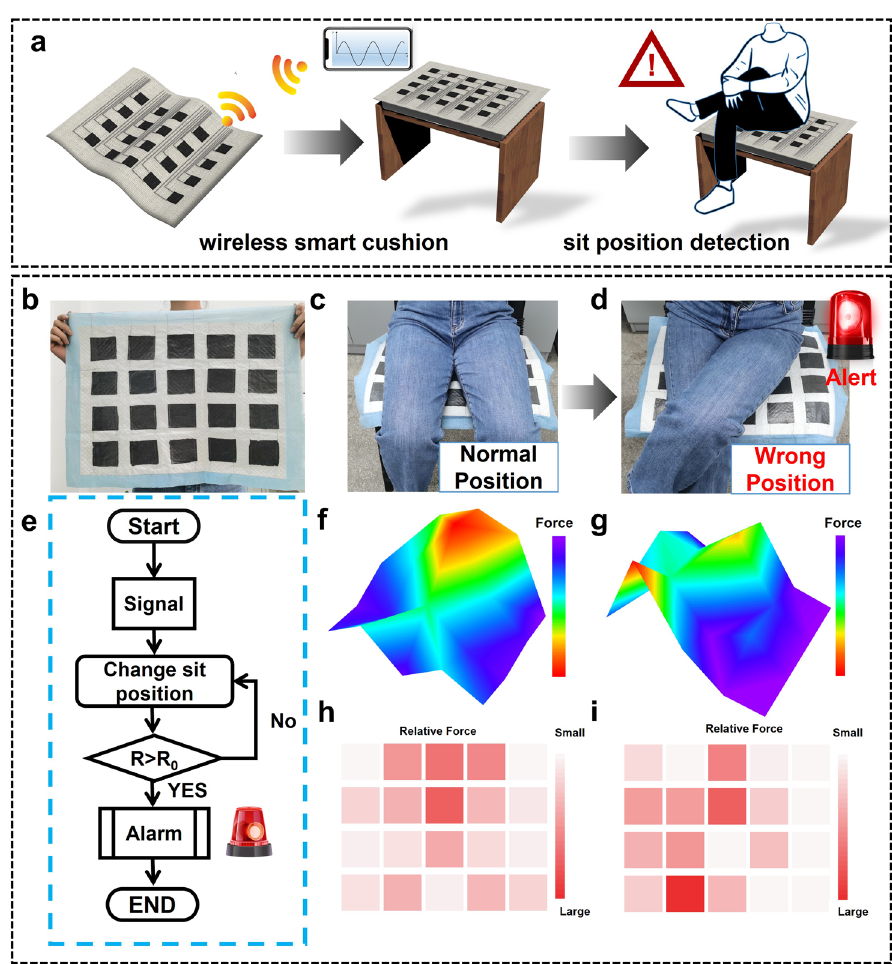
Fig. 10 Wireless smart cushion system in detecting sitting postures. a Schematic diagram of wireless smart cushion system. b Digital image of smart cushion. (45 cm × 60 cm, 4 × 5 arrays). Digital image of detecting sitting postures at c normal position and d wrong position. e Flow chart of the wrong sitting position alarm principle. Cloud map of f normal and g incorrect sitting obtained from detection points. Thermal map of h normal and i incorrect sitting obtained from detection points. The data indicate the relative pressure converted by the change in